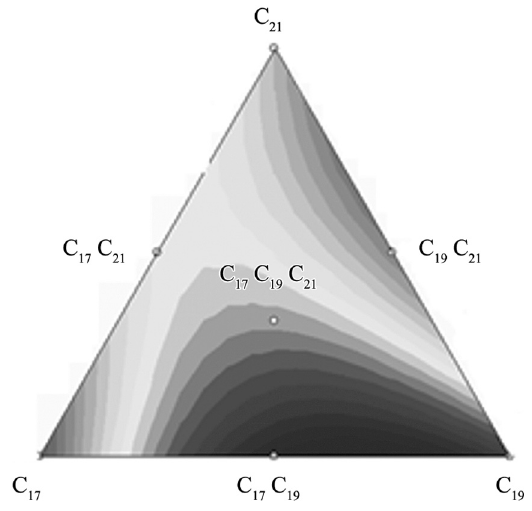
Figure 2. Three-component simplex-centroid experimental model.